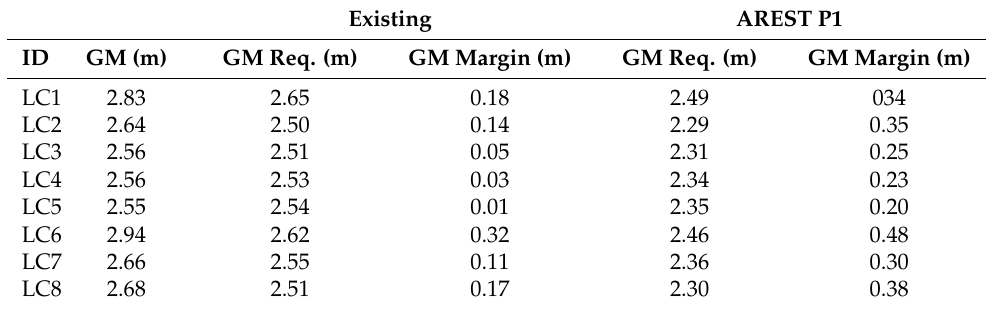
Table 9. Loading conditions and GM margins for cruise ship C1 with AREST P1 reconfiguration. Existing